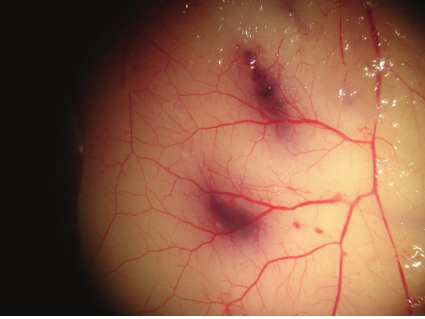
Figure 1: Typical picture of newly-formed blood vessels.